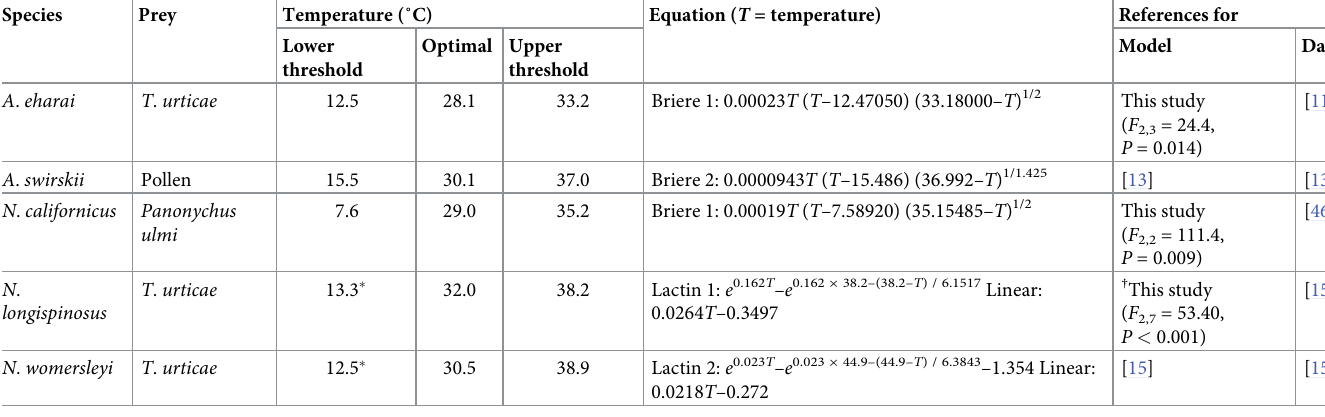
Table 7. The parameters and equations of temperature-dependent r models and lower- and upper threshold, and optimal temperatures for the two-spotted spider mite, Tetranychus urticae , and selected phytoseiid mites from this study and the literature. Species